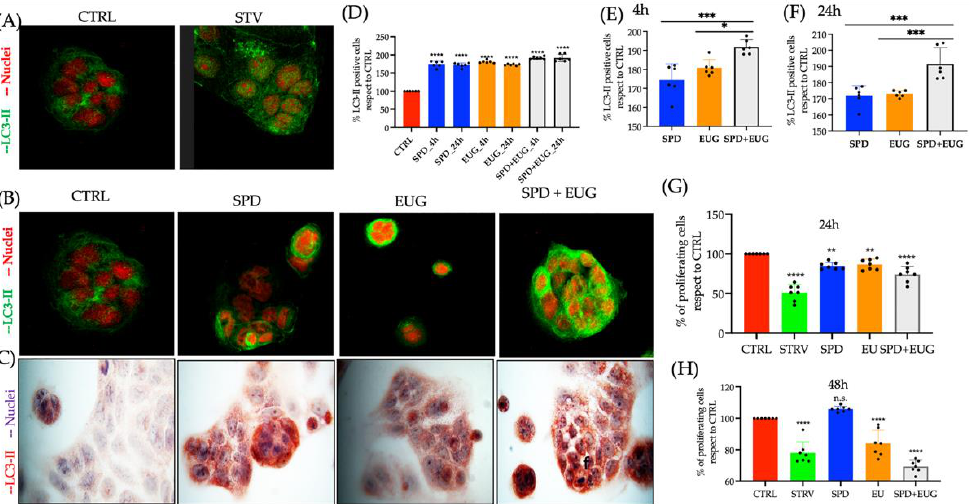
Figure 4. The effect of 0.3 mM spermidine (SPD) and 0.2 mM eugenol (EUG), alone and in combination (0.3 mM SP + 0.2 mM EUG) on LC3-II activation and viability in Caco-2 cell lines. ( A ) LC3-II staining in the untreated control cells), and the starvation (STARV)-induced control cells was detected with immunofluorescence green staining (FG) after 4 h. ( B , C ) For the SPD, EUG and SPD + EUG treatments, LC3-II was detected with FG staining and fast red chromogen staining. ( D – F ) Statistical analysis of the LC3-II positive cells stained with red chromogen was performed after both 4 h and 24 h from the start of all treatments. MTT assay performed after 24 h ( G ) and 48 h ( H ) on Caco-2 cells that were untreated or treated with SPD, EUG and SPD + EUG. The number of stars *, **, *** and **** represents significant differences between treatments as determined by one-way ANOVA at the 99% confidence level ( p < 0.01), whereas n.s. is not